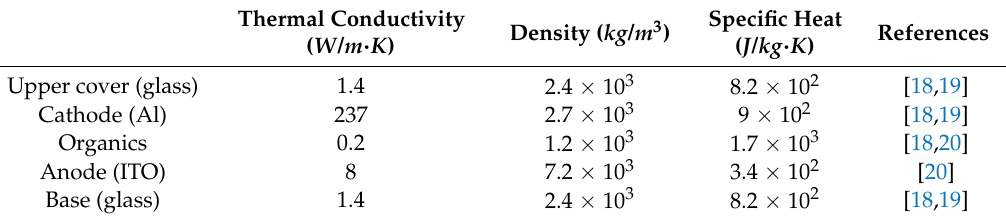
Table 2. Parameters of the layers in the thermal sub-model.